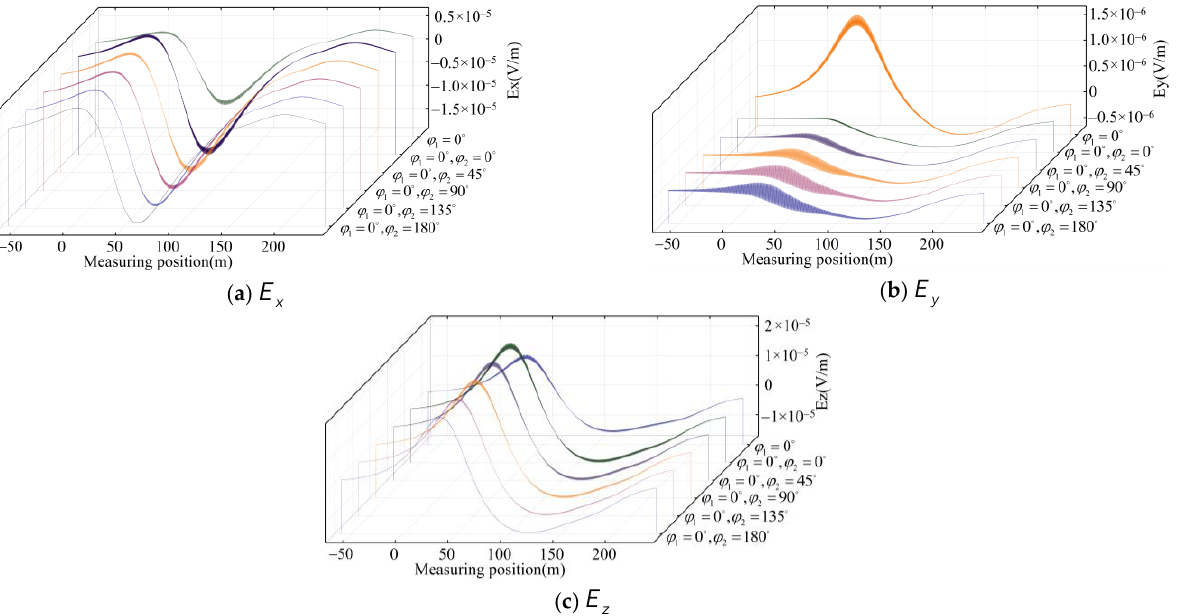
Figure 9. Distribution of ship’s mix ed electric field XYZ component.